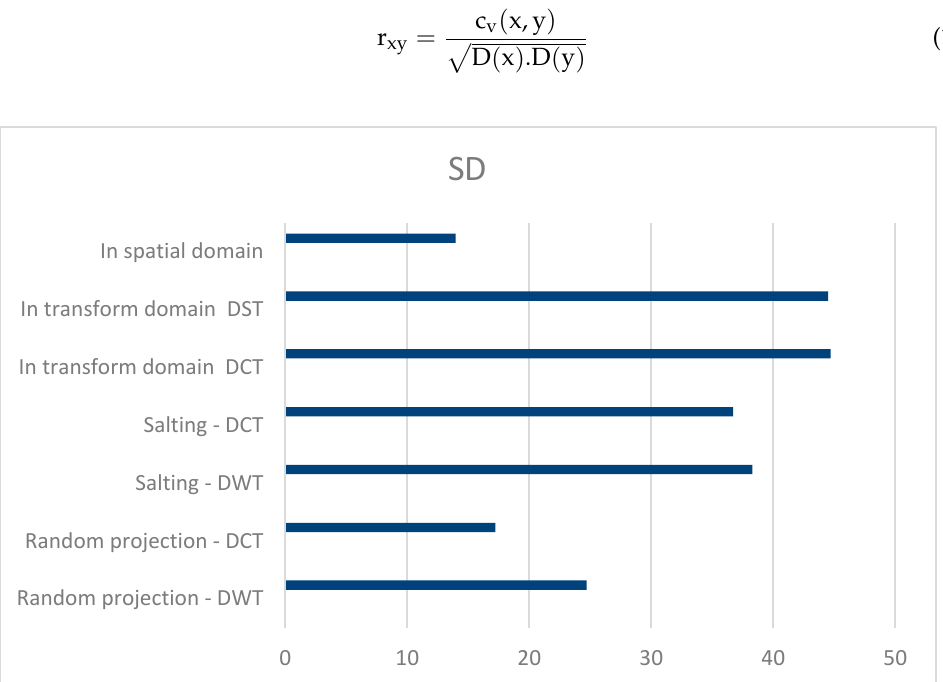
Table 2. Comparison of various encryption schemes using the evaluation metrics.